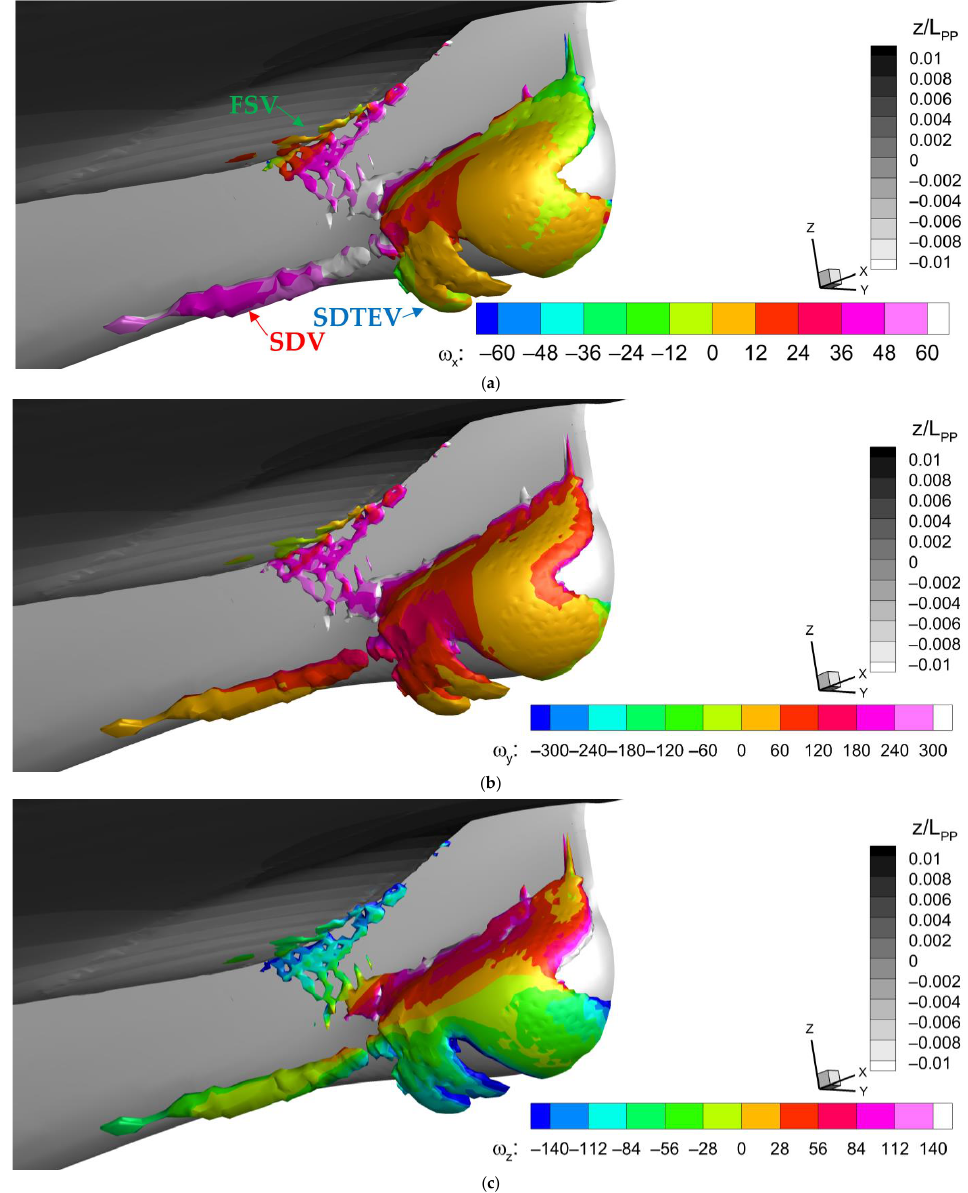
Figure 15. Vortical structures around the original sonar dome (isosurface of Q = 500) with the contour flooded by the color of: ( a ) x -vorticity ( ω x ); ( b ) y -vorticity ( ω y ); ( c ) z -vorticity ( ω z